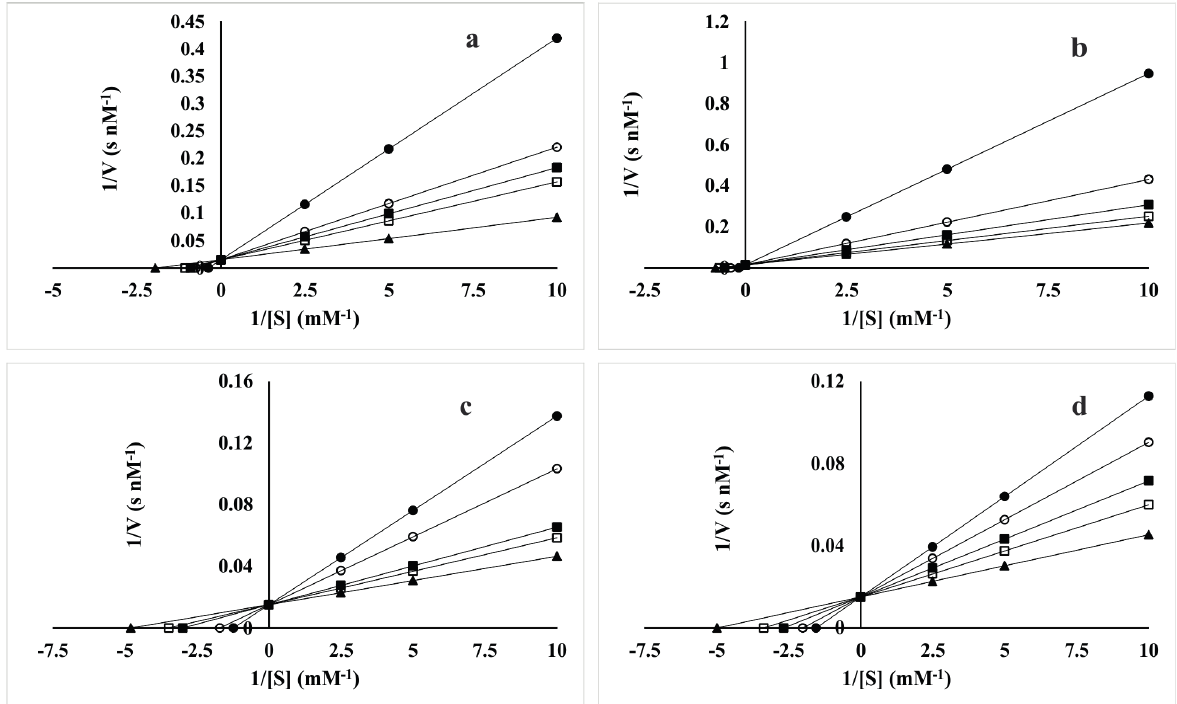
Figure 3. Lineweaver-Burk graphic of the inhibition (I) of the intestinal trypsin- like of Anticarsia gemmatalis (Lepidoptera: Noctuidae) by the inhibitors ( a ) benzamidine, ( b ) berenil, ( c ) SKTI and ( d ) SBBI in the presence of L-BApNA substrate. The lines were calculated by linear regression using the parameters of Table II. The points are experimental. I1 ( ), I2 (  ), I3 ( ■ ), I4 (  ), I5 ( ●